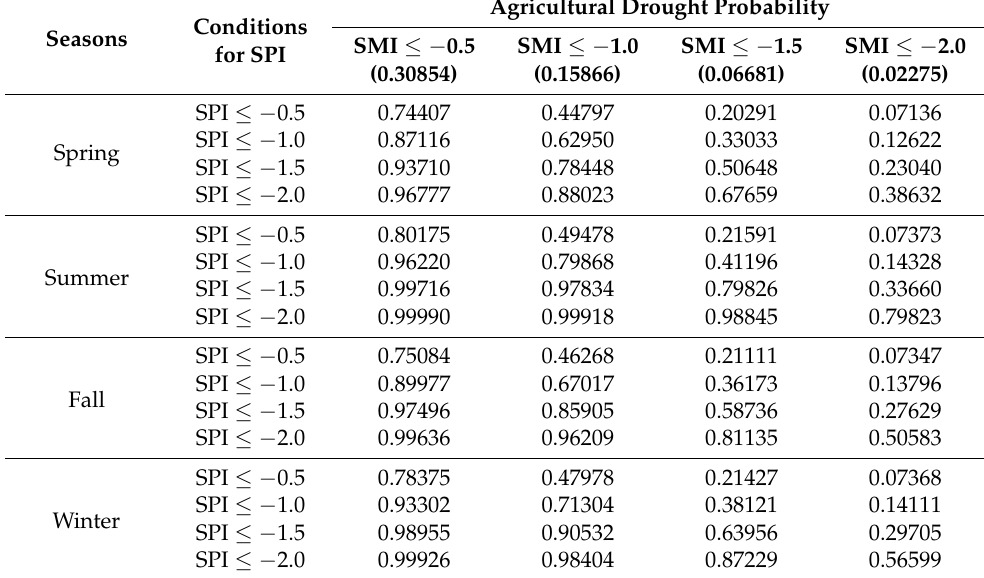
Table 3. Propagation probability of agricultural drought under various seventies of meteorological drought at Andong Dam Basin.